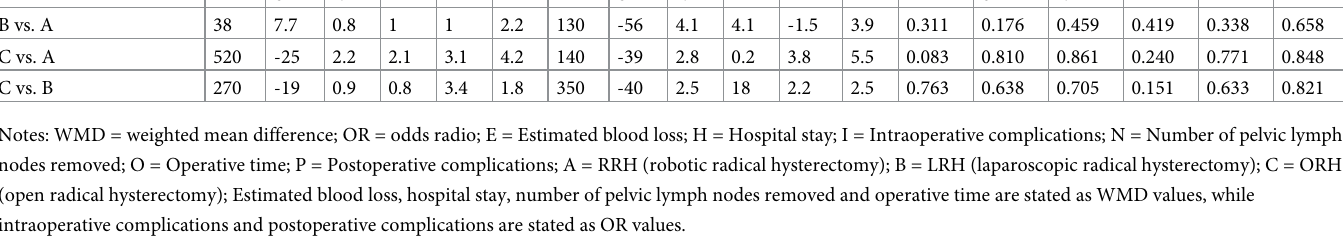
Table 3. WMD/OR values and P values of direct and indirect pairwise comparisons of three treatment modalities under six endpoint outcomes. Pairwise comparisons Direct WMD/OR values